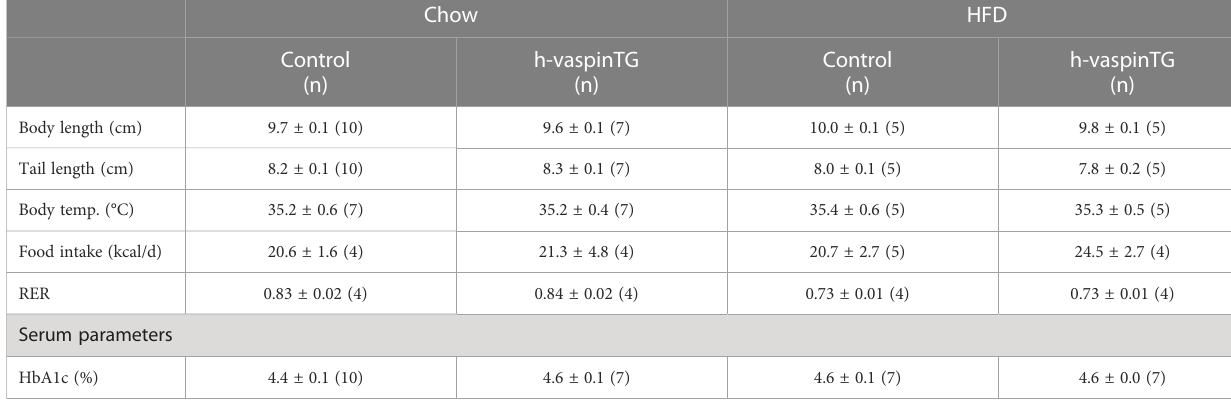
TABLE 1 Anthropometric and metabolic parameters in male chow and high-fat diet (HFD)-fed h-vaspinTG and control